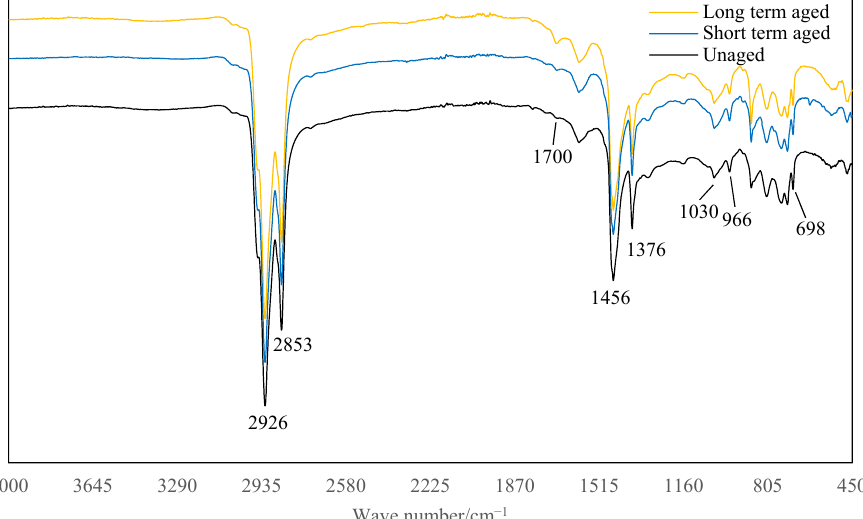
Figure 8. FTIR spectrum of asphalt extracted from LFSMA-13.